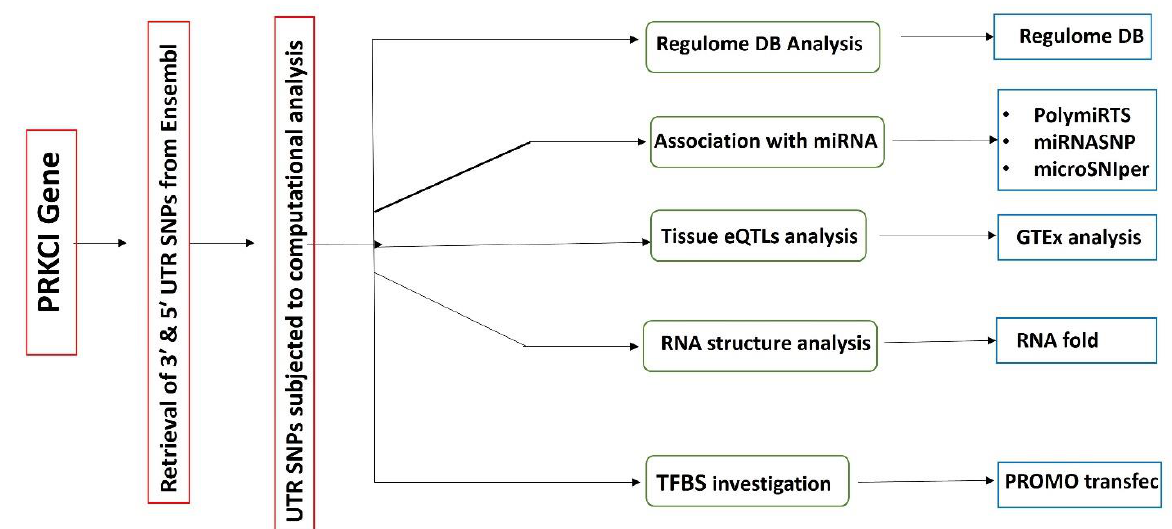
Figure 1. Flowsheet of methods involved in study.